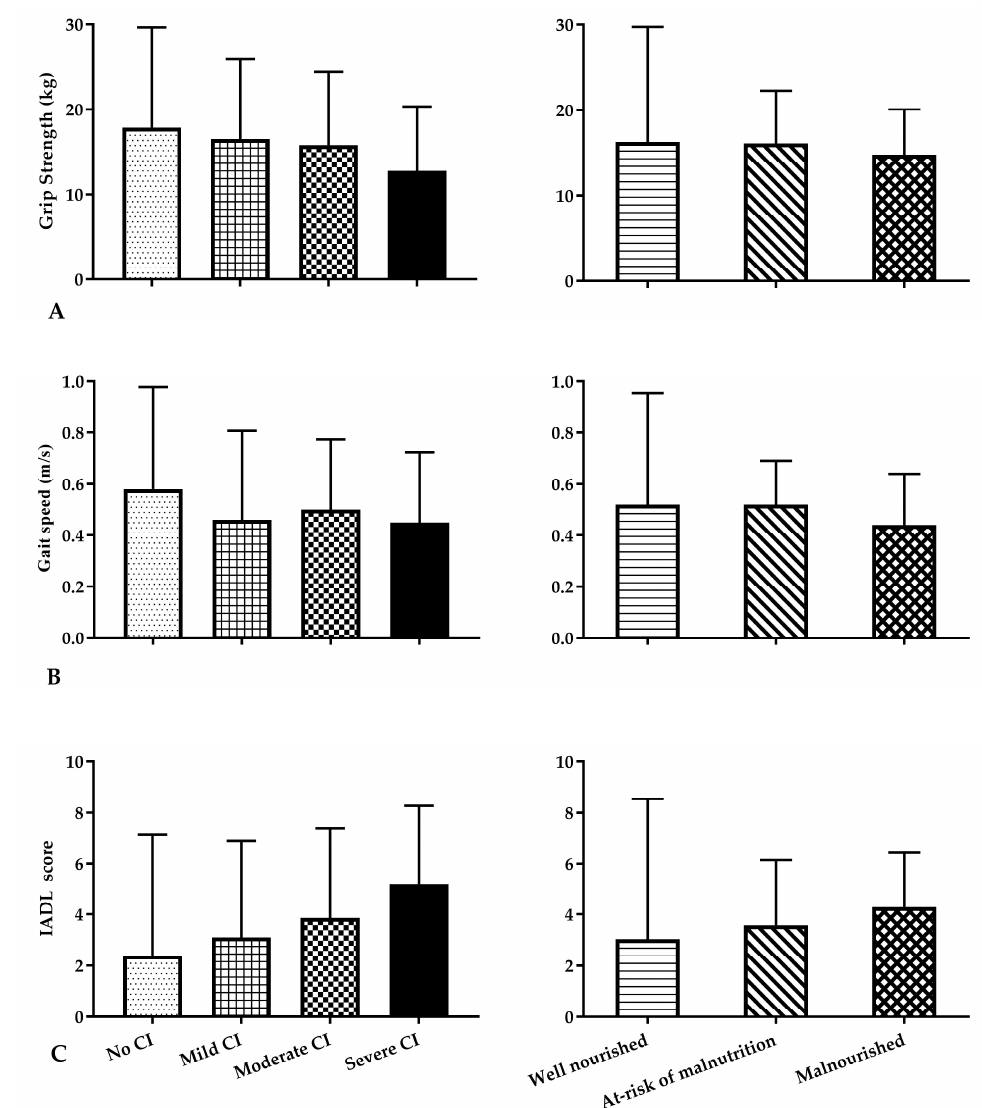
Figure 2. Grip strength ( A ), gait speed ( B ) and IADL ( C ) according to cognitive (left hand column) and nutritional status (right hand column) a . a Data presented is age adjusted Mean ± SEM. Age adjusted p value for cognitive function effect adjusted for age, gender and location; p value for cognitive function effect ( A ) = 0.019, ( B ) = 0.019, ( C ) < 0.01; p value for nutritional status effect ( A ) = 0.47, ( B ) = 0.15, ( C ) = 0.09; p value for interaction of cognitive function by nutritional status ( A ) = 0.62, ( B ) = 0.40, ( C ) = 0.83.